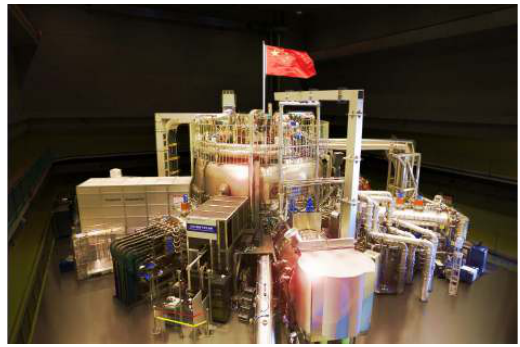
Fig. 1 The photo of Experimental Advanced Superconducting Tokamak (EAST) in Hefei, China.